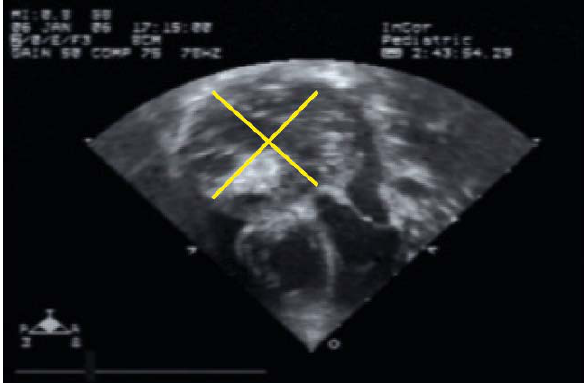
Fig. 2 – Ecocardiograma demonstrando grande massa intrapericárdica delimitada pelas linhas